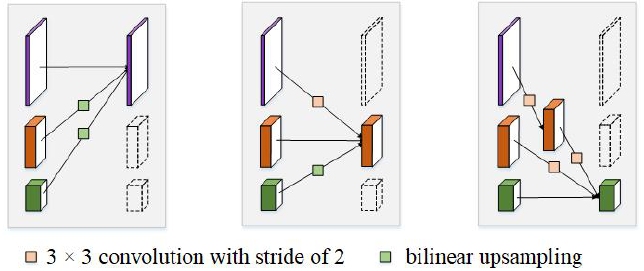
Figure 5. An example illustrating the low-to-high process and the high-to-low process for multi- resolution fusions. Resolution increase from 1/2 to 1 and that from 1/4 to 1 both simply use bilinear upsampling. Resolution decrease from 1 to 1/2 needs one strided convolution and that from 1 to 1/4 needs two consecutive strided convolutions.